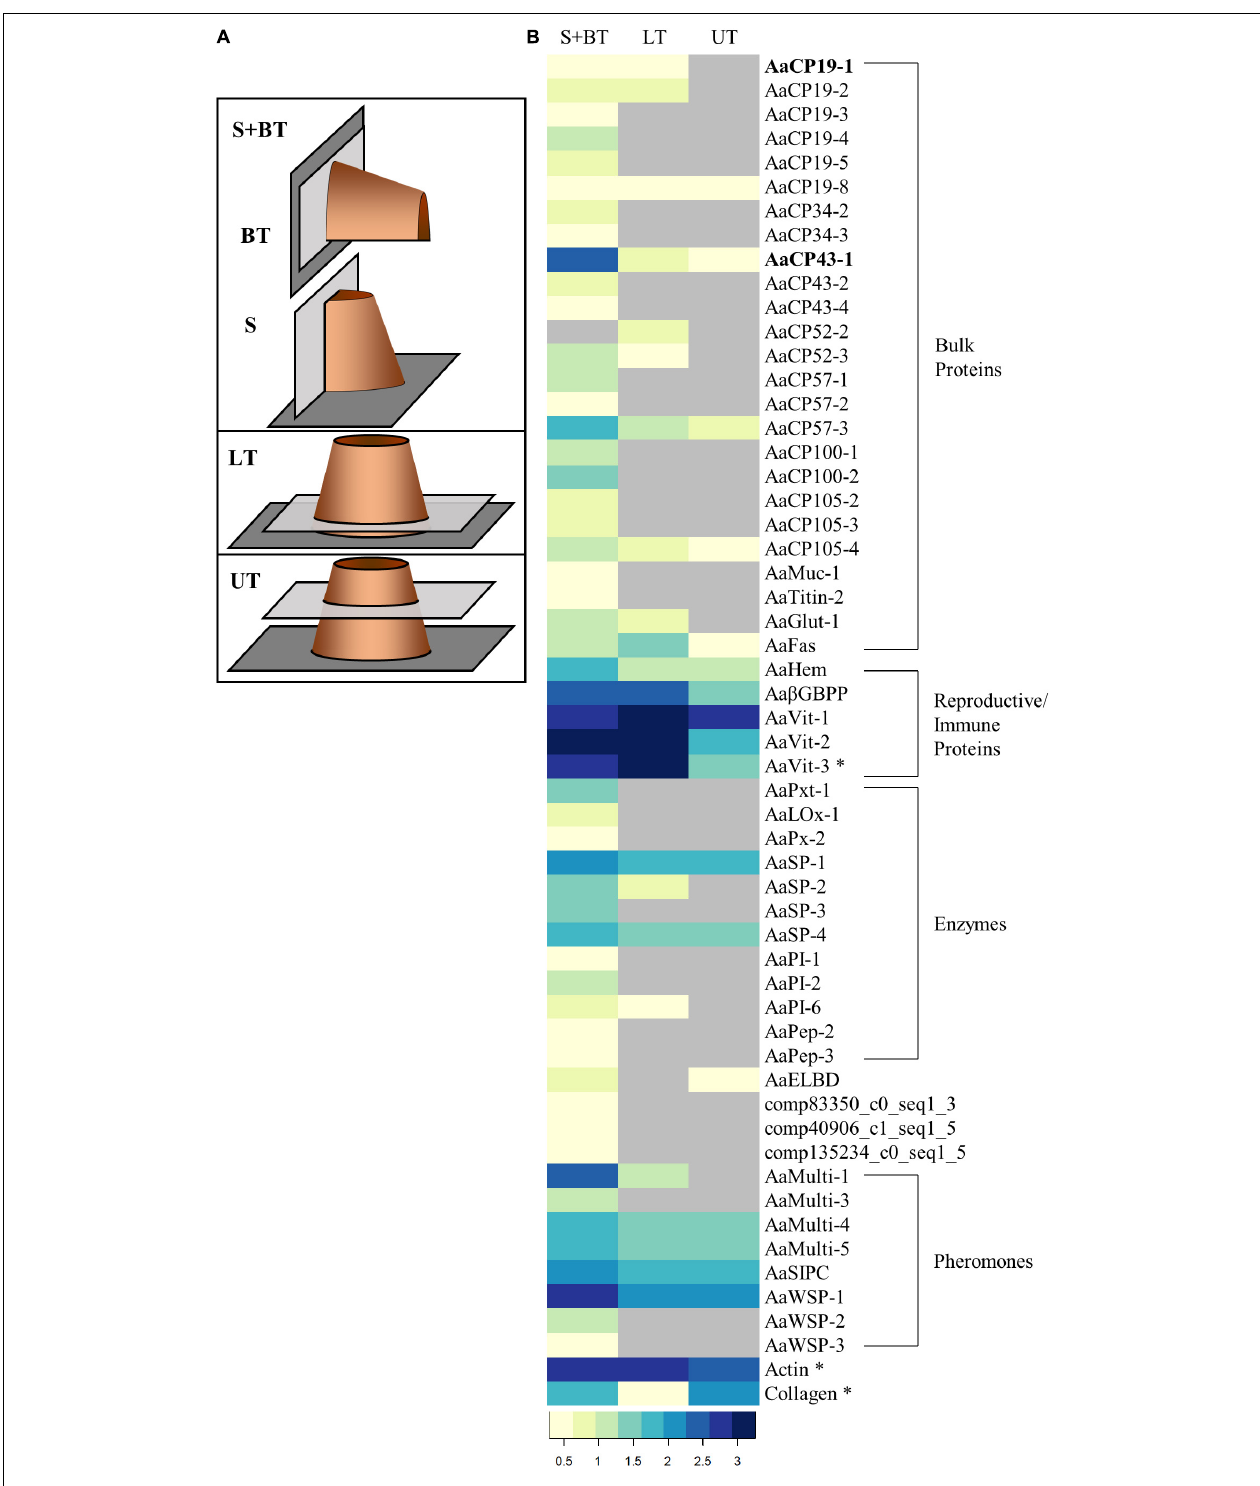
FIGURE 5 | Proteomic analysis of FFPE sections. (A) Schematic representations indicating the location (light gray rectangles) of the sections along a barnacle (orange cylinder) settled on a substrate (dark gray rectangle) analyzed for proteomics. Sagittal = S; BT = Basal Transverse; LT = Lower Transverse; UT = Upper Transverse. S and BT sections were combined (S + BT). The locations indicated here match exactly with the sections in Figure 1 . (B) Heatmap illustrating total spectrum counts (log10 transformed) for S + BT, LT, and UT FFPE sections. The proteins are grouped by predictive function: bulk proteins that compose adhesive at the interface; proteins that play a role in reproduction and/or immunity; and pheromones. Gray cells indicate no identification. Asterisks indicate proteins that have not been identified in the adhesive previously. AaCP19-1 and AaCP43-1 identifiers are in bold.